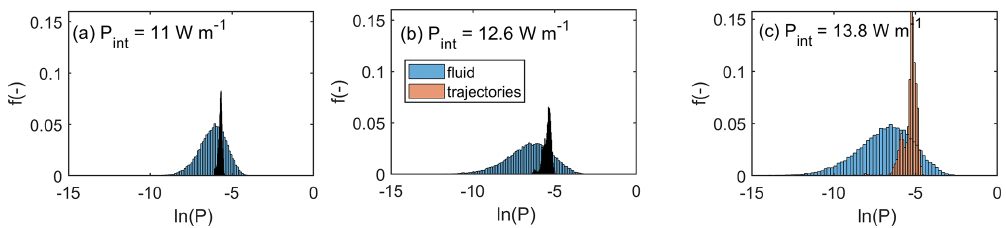
Figure 6. Cumulative distributions of ln( P ) in the flow domain (blue) and of ln( P) averaged along the particle trajectories for (a) σ 2 = 1, (b) σ 2 = 3, and (c) σ 2 =